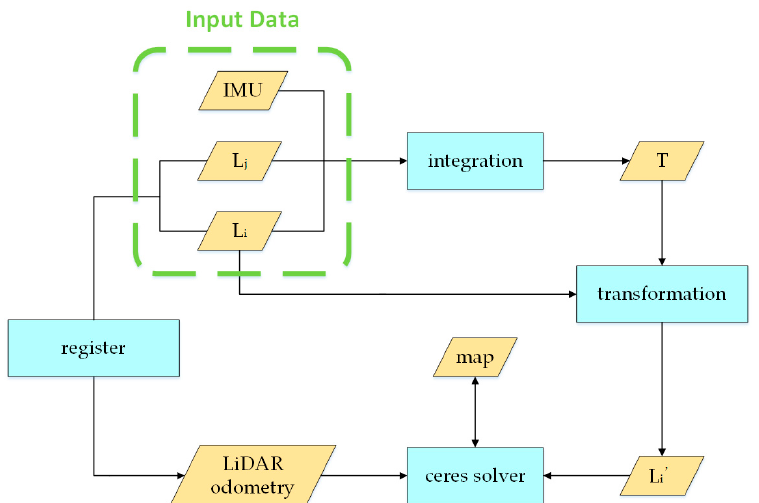
Figure 3. De-skewing system framework.